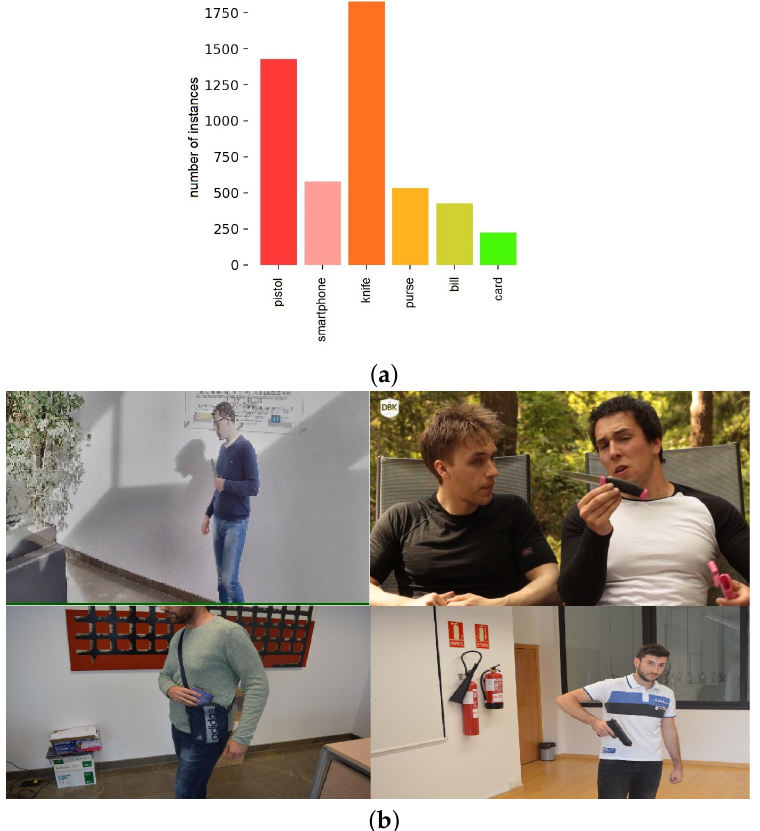
Figure 3. SOHAs_weapons dataset. ( a ) Class distribution of training dataset. ( b ) Sample images from the